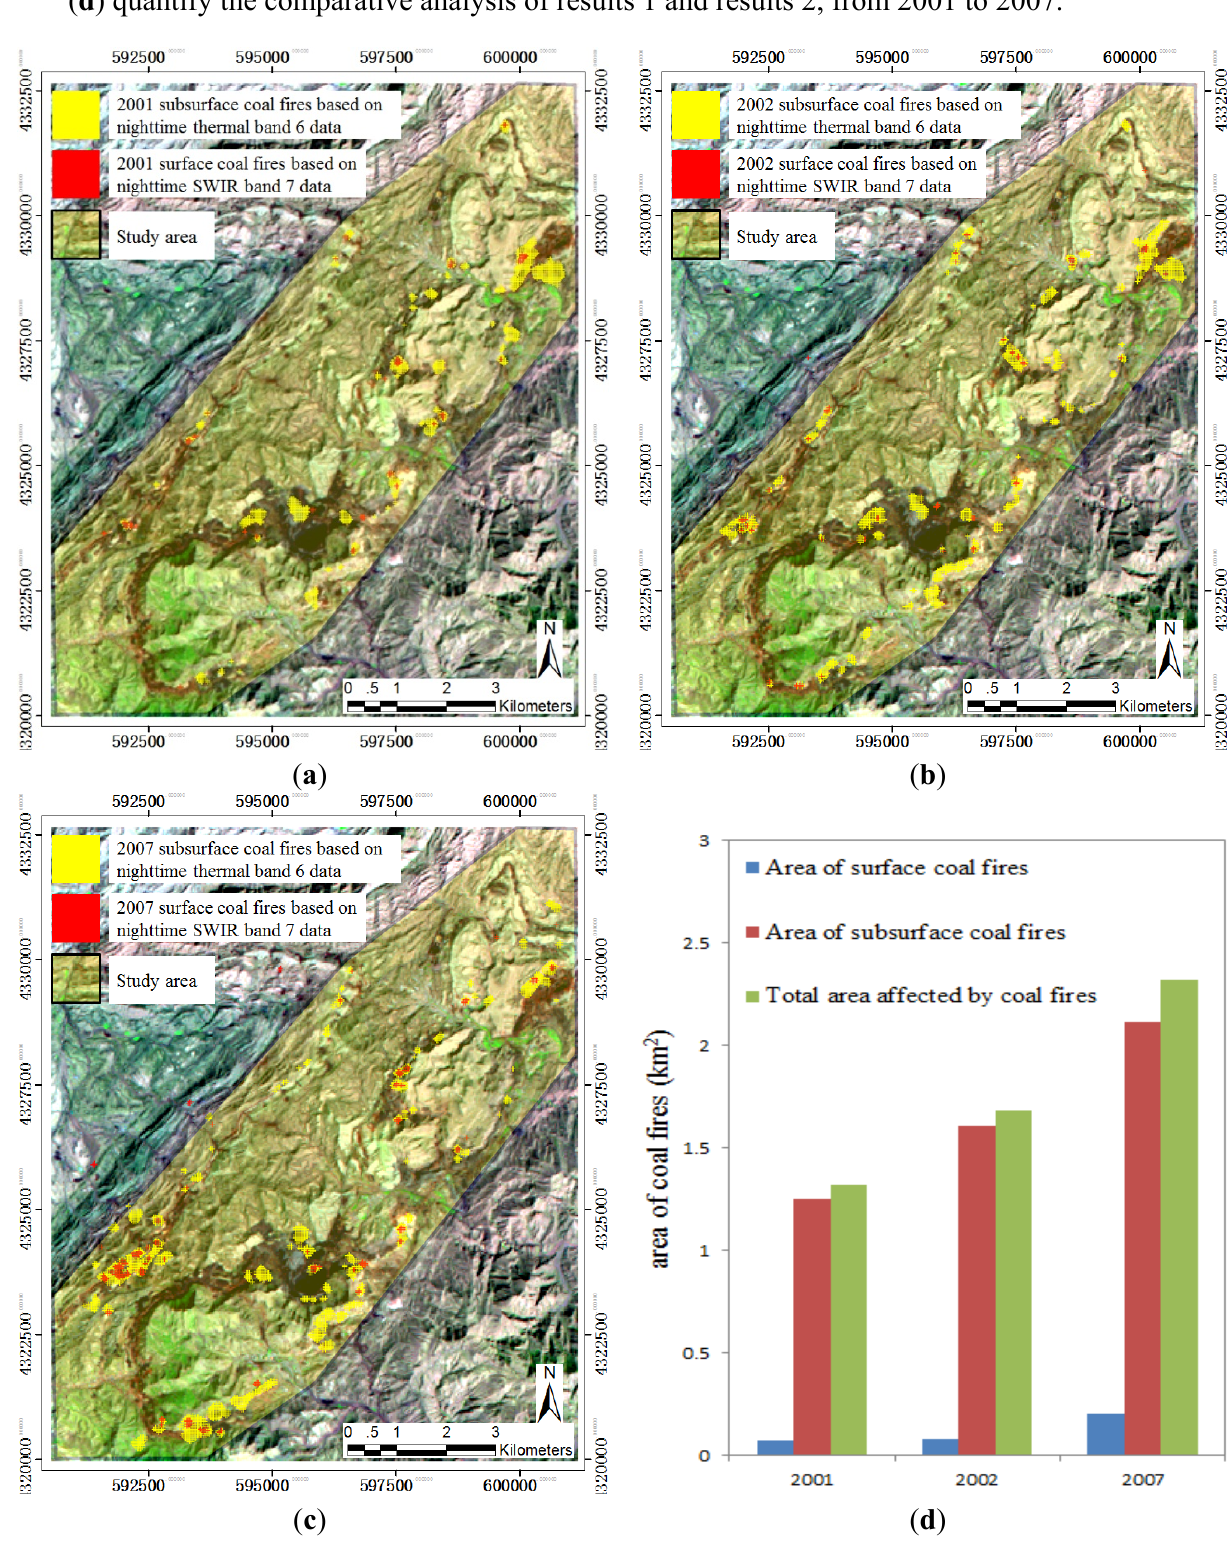
Figure 8. Comparative analysis between the results of subsurface coal fires from thermal band 6 data and the respective results of surface coal fires from SWIR band 7